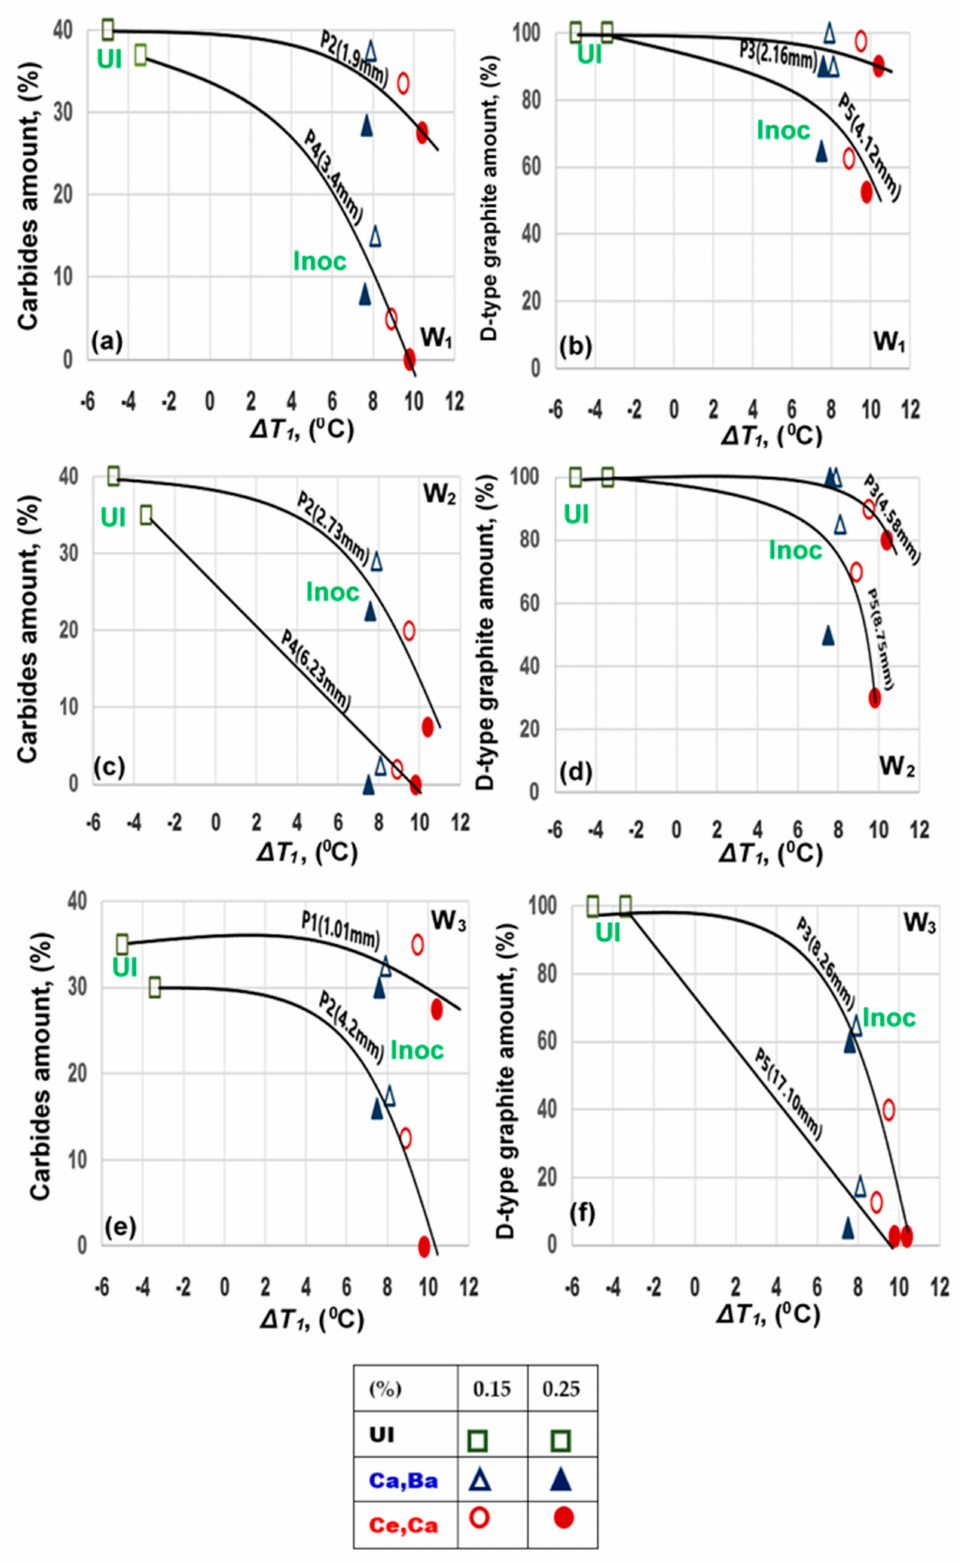
Figure 9. Influence of undercooling at the lowest eutectic temperature ( ∆ T 1 ), or metastable eutectic temperature, on the carbides amount ( a , c , e ) and undercooled (D-type) graphite amount ( b , d , f ) at different thicknesses of the wedge samples (W 1 , W 2 , W 3 ) (UI/Inoc—un-inoculated and inoculated (Ca,Ba/Ce,Ca) grey cast irons) (P1 . . . P5—analysed points on the wedge samples, Figure